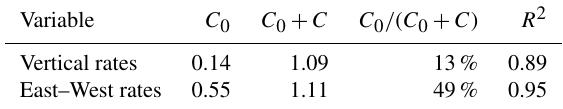
Table 1. Characteristic parameters of the